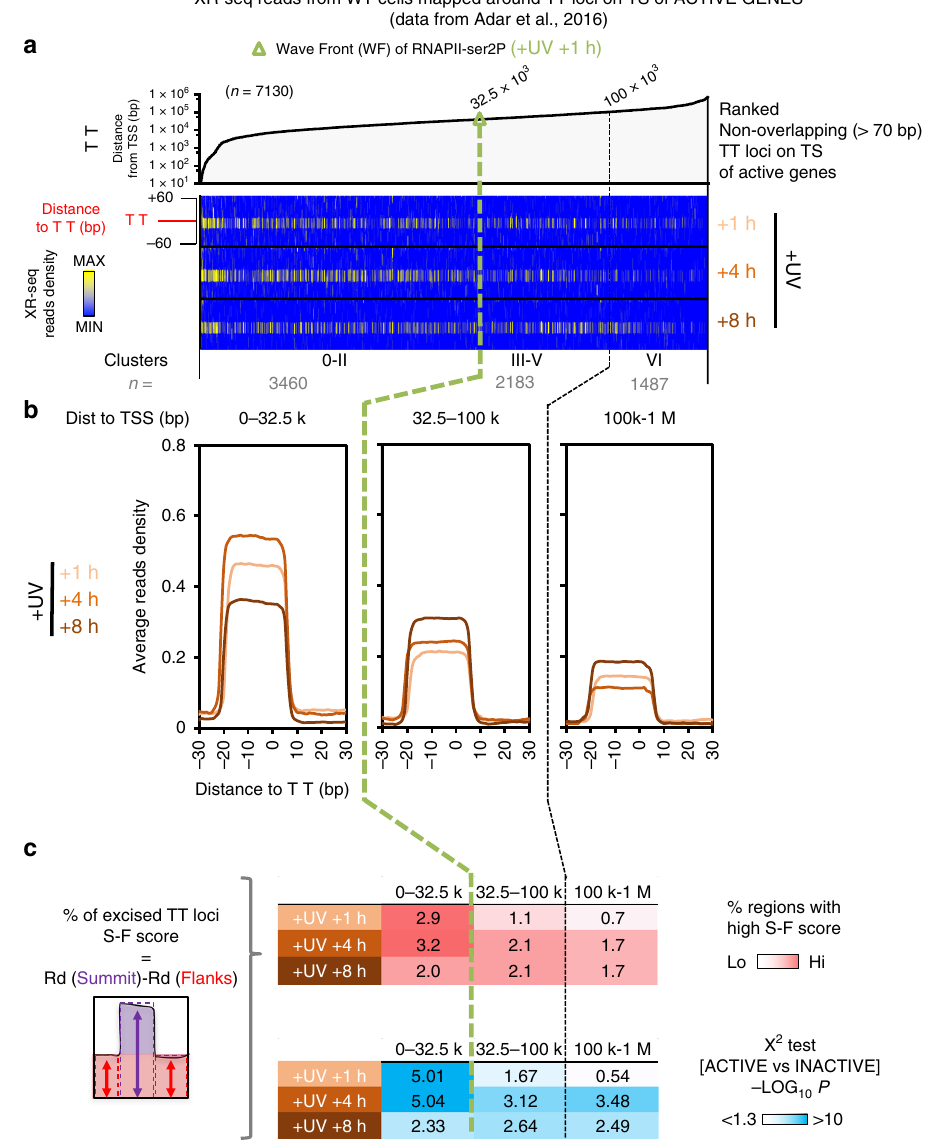
Fig. 8 Continuous initiation maintains TC-NER ef fi ciency during the whole recovery period and across the whole transcribed region. a Distribution of XR-seq reads derived from WT cells at 1, 4, and 8 h post UV irradiation. Reads were aligned on TT loci of the transcribed strand (TS) of active genes. Data were obtained from ref. 46 . Pol II-ser2P wave front position (WF = 32.5 kb) was de fi ned at + UV ( + 1 h) in ref. 25 . b Average plots of read densities shown in a for the respective clusters. c Heatmaps showing the percentage (%) of excised TT loci, as calculated by the difference between Rd at summit (S) and Rd at fl anks (F) (S – F score) from all clusters presented and analyzed in a and b with high “ S – F ” scores (>threshold = average “ S – F ” + 3 × SD, as calculated for the control exon start regions, see ref. 25 ) (see “ Methods ” for